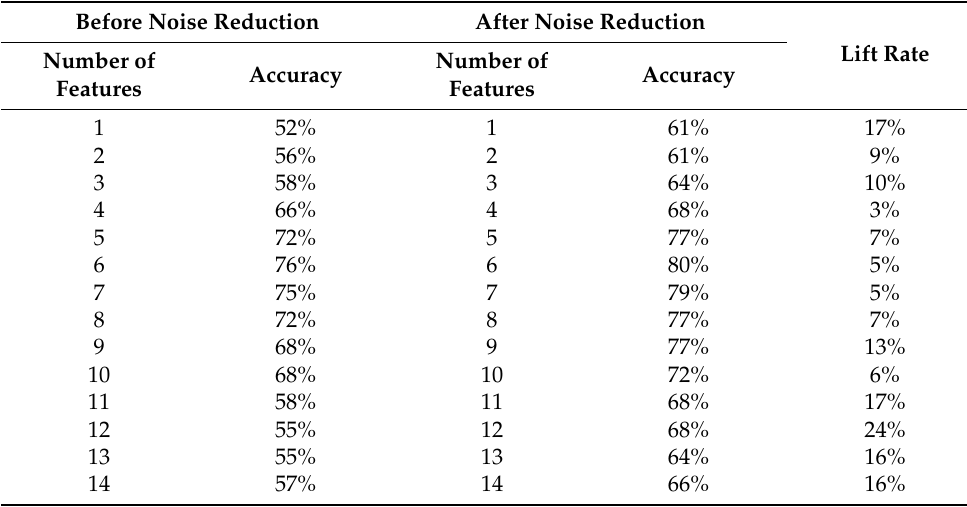
Table 12. The accuracy of the tool life cycle model after noise reduction. Before Noise Reduction After Noise Reduction